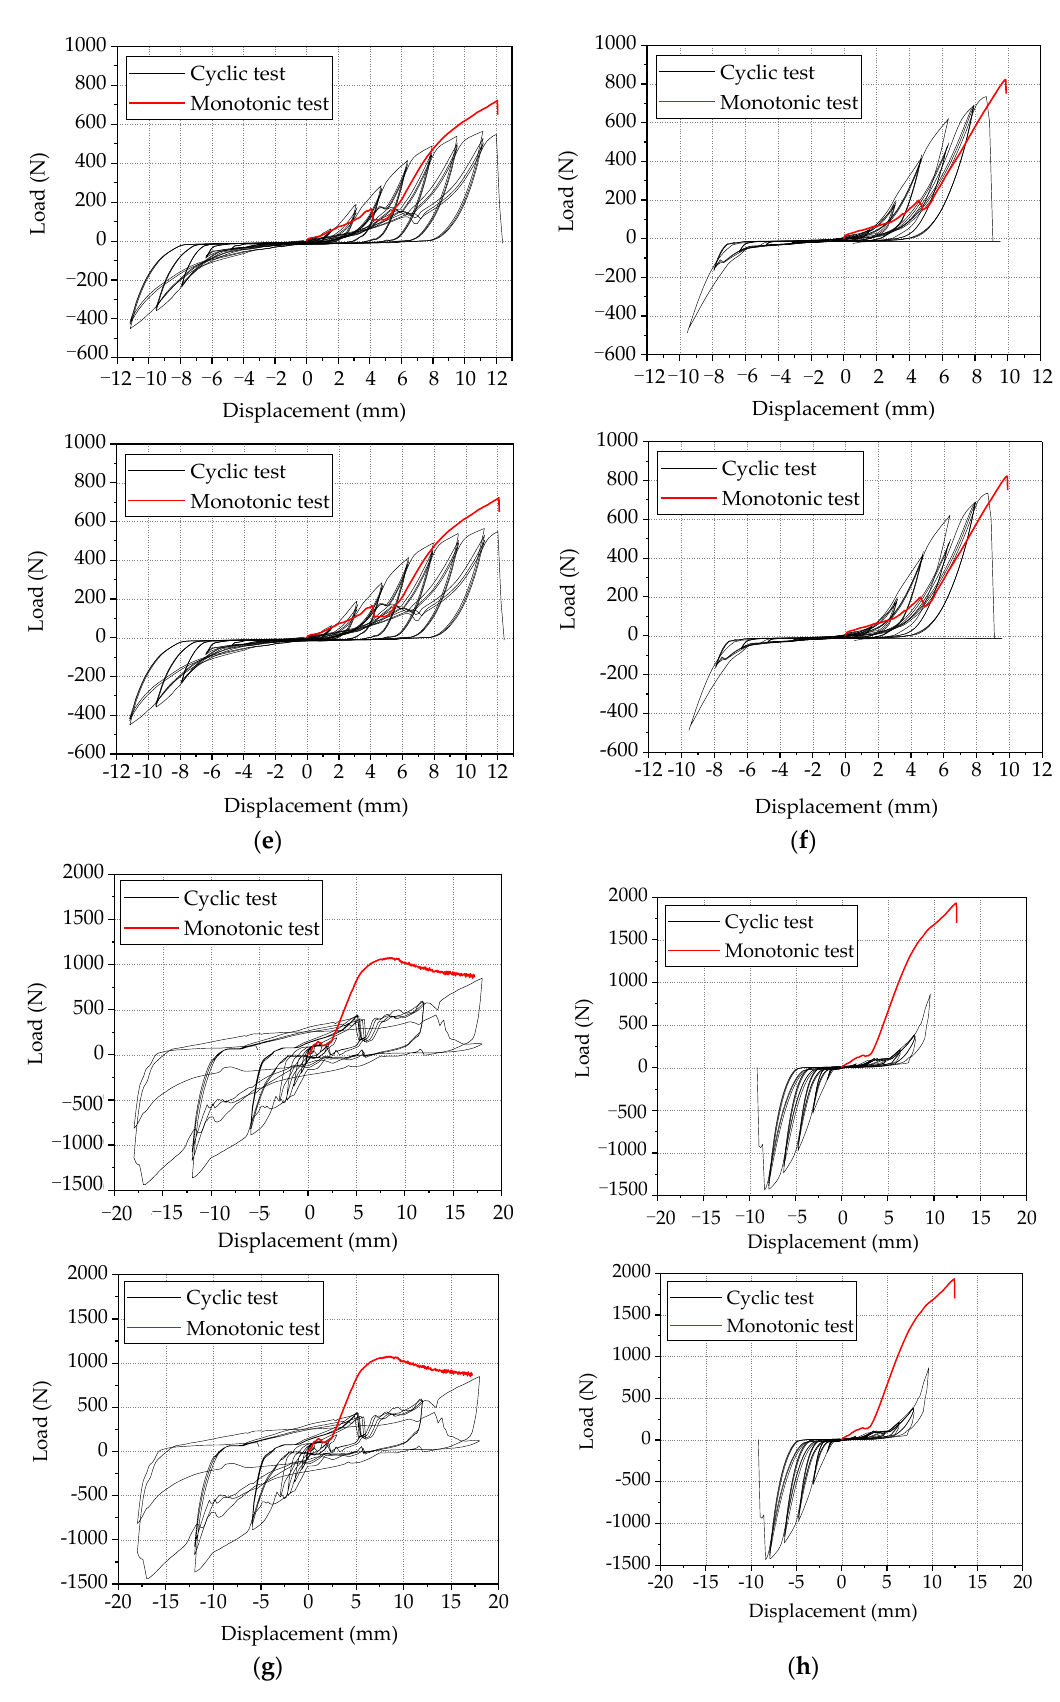
Figure 5. Load–displacement curves of the test specimens: ( a ) CSN, ( b ) CSS, ( c ) CBN, ( d ) CBS, ( e ) PSN, ( f ) PSS, ( g ) PBN, ( h ) PSS.